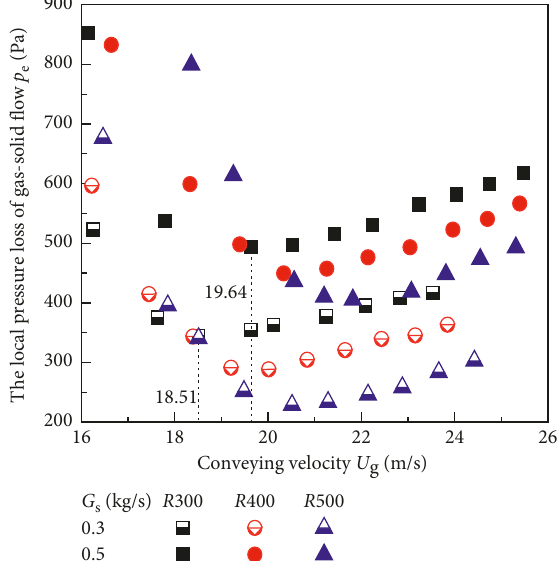
Figure 5: The local pressure loss of gas-solid flow for the different 0.3 and bend radii at G s (cid:31)